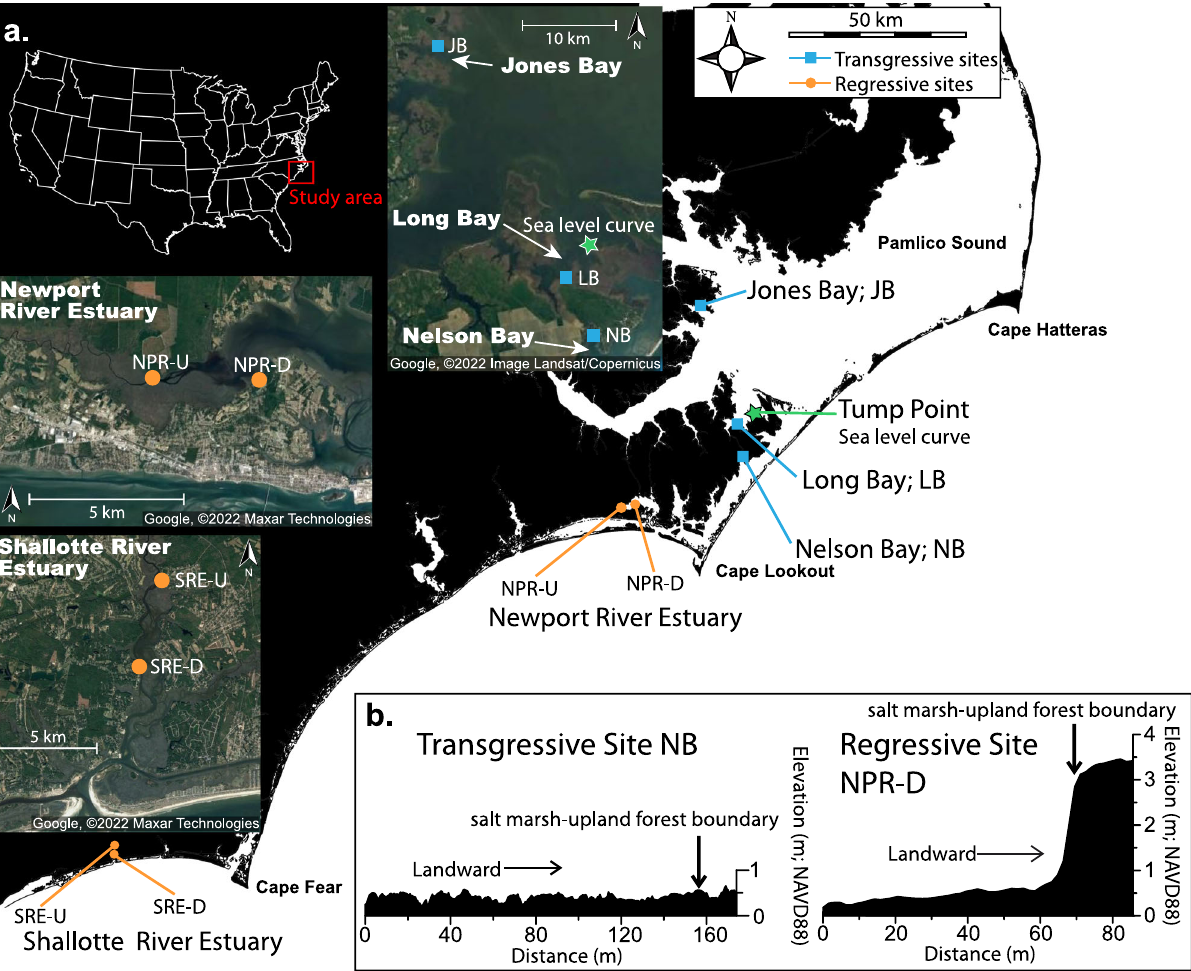
Fig. 2 Location of study sites in North Carolina, USA. Transgressive and regressive fringing salt marsh sites are located north and west of Cape Lookout, respectively ( a ). Representative topographic pro fi les ( b ) showing low gradient upland and wide salt marsh at transgressive sites (Nelson Bay NB) and high gradient upland and narrow salt marsh at regressive sites (Newport River Estuary NPR-D). The Tump Point sea-level curve is indicated by the green star 38 . COMMUNICATIONS EARTH & ENVIRONMENT| (2022) 3:173